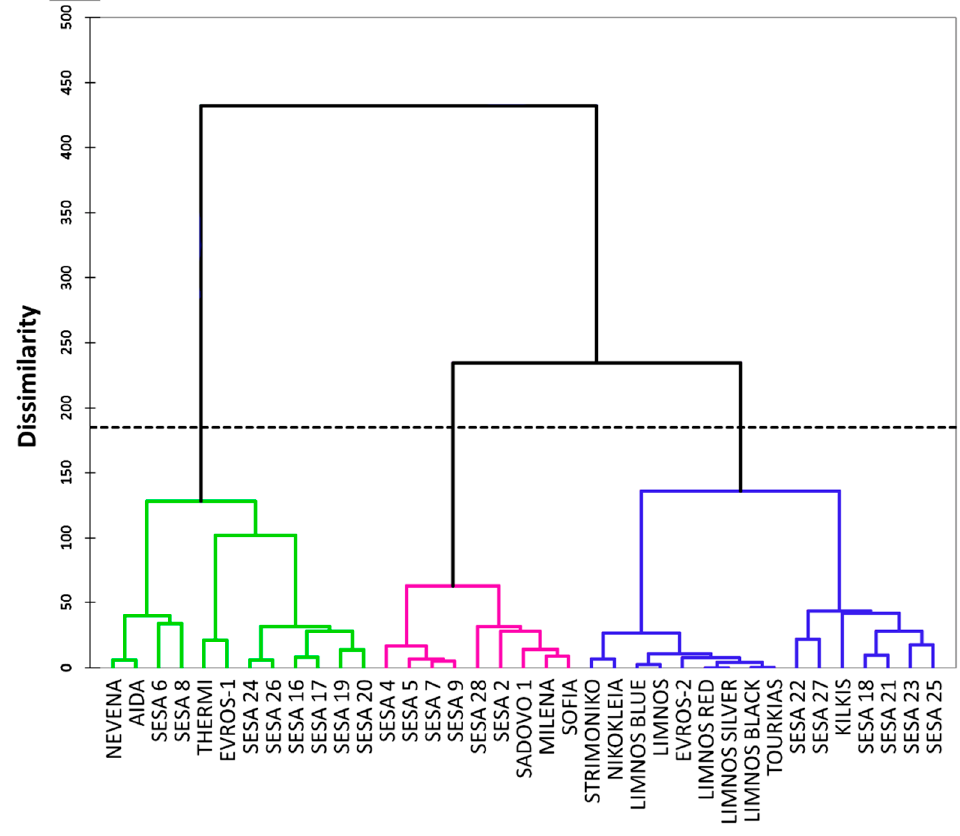
Figure 4. Dendrogram of the agglomerative hierarchical clustering (AHC) for the 37 sesame cultivars based on 28 morpho-physiological traits. Table 3. Diversity statistics for seven expressed sequence tag-simple sequence repeat (EST-SSR) loci studied in 35 sesame landraces. Data are presented as mean values ± standard errors for each locus.